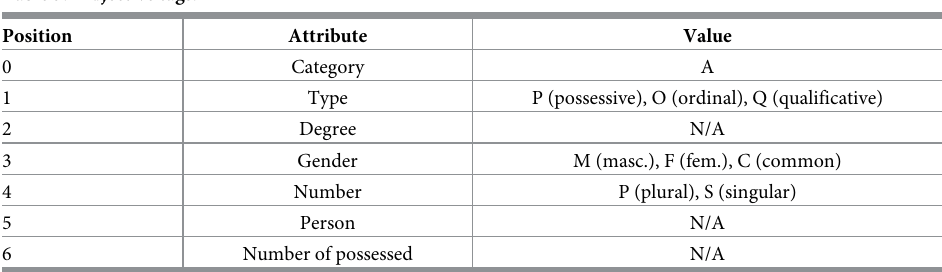
Table 5. Adjective tags.